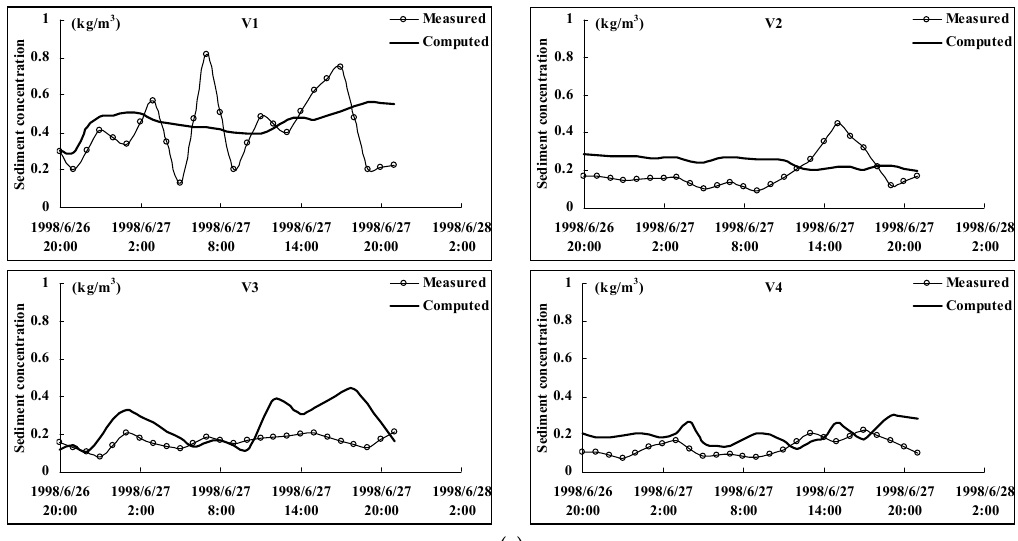
Figure 5. The comparison between the numerical results and the measured data: from 26 June 1998 20:00 to 27 June 1998 21:00. ( a ) The comparison between the computed and measured tidal levels; ( b ) The comparison between the computed and measured flow velocities and directions; ( c ) The comparison between the computed and measured sediment concentration.